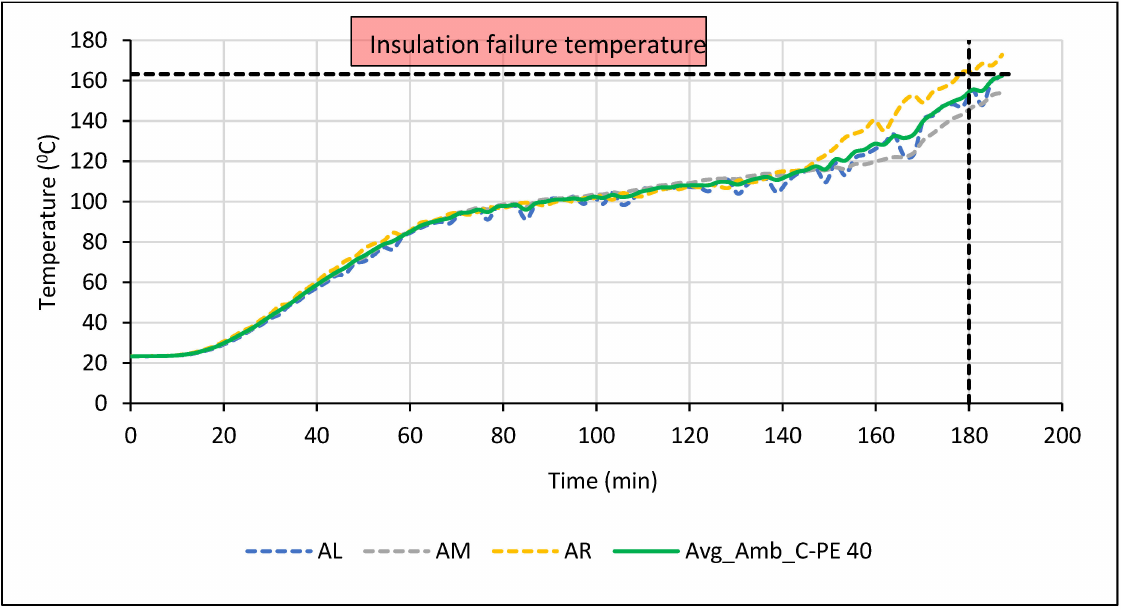
Figure 33. Ambient side surface time–temperature curves of C-PE 40 block from the building fire